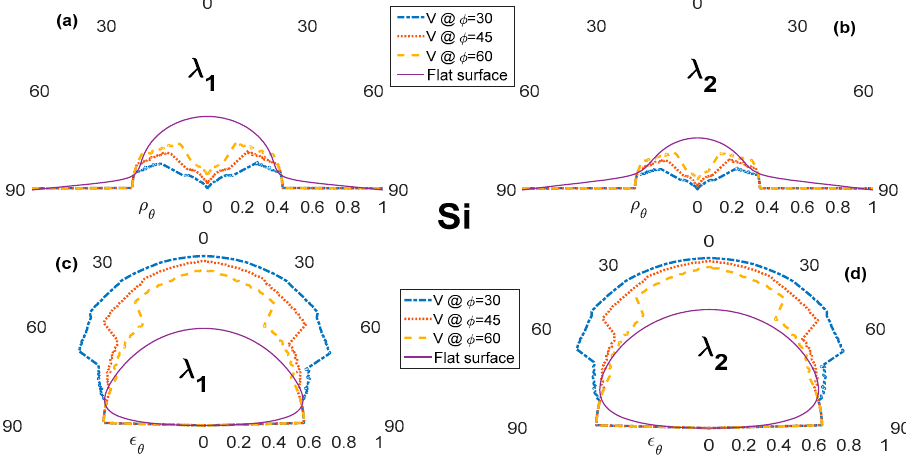
Figure 14. ( a , b ): Directional reflectivity; ( c , d ): apparent emissivity of a V-cavity and flat surface formed of gold in two different spectral ranges [ λ 1 , λ 2 ], at different opening angles φ = [30 ◦ , 45 ◦ , 60 ◦ ].